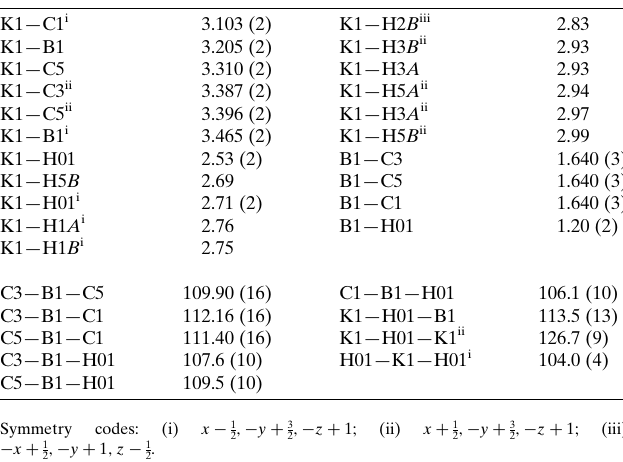
Table 1 Selected geometric parameters (A˚ , (cid:4) ).